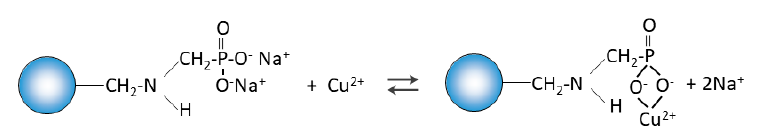
Figure 15. Forms of ion exchangers in acidic solution.